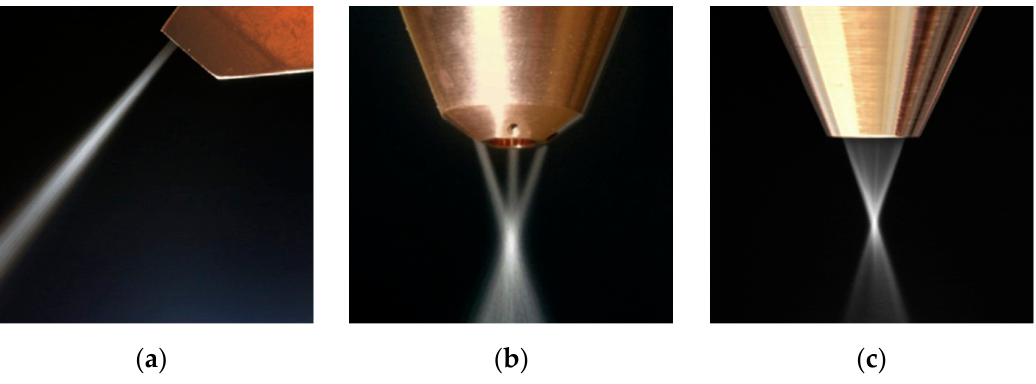
Figure 4. Deposition head configurations: ( a ) lateral configuration, ( b ) discrete coaxial configuration, and ( c ) continuous coaxial configuration (adapted from [48]). Table 2. Advantages and disadvantages of deposition head configurations [48].